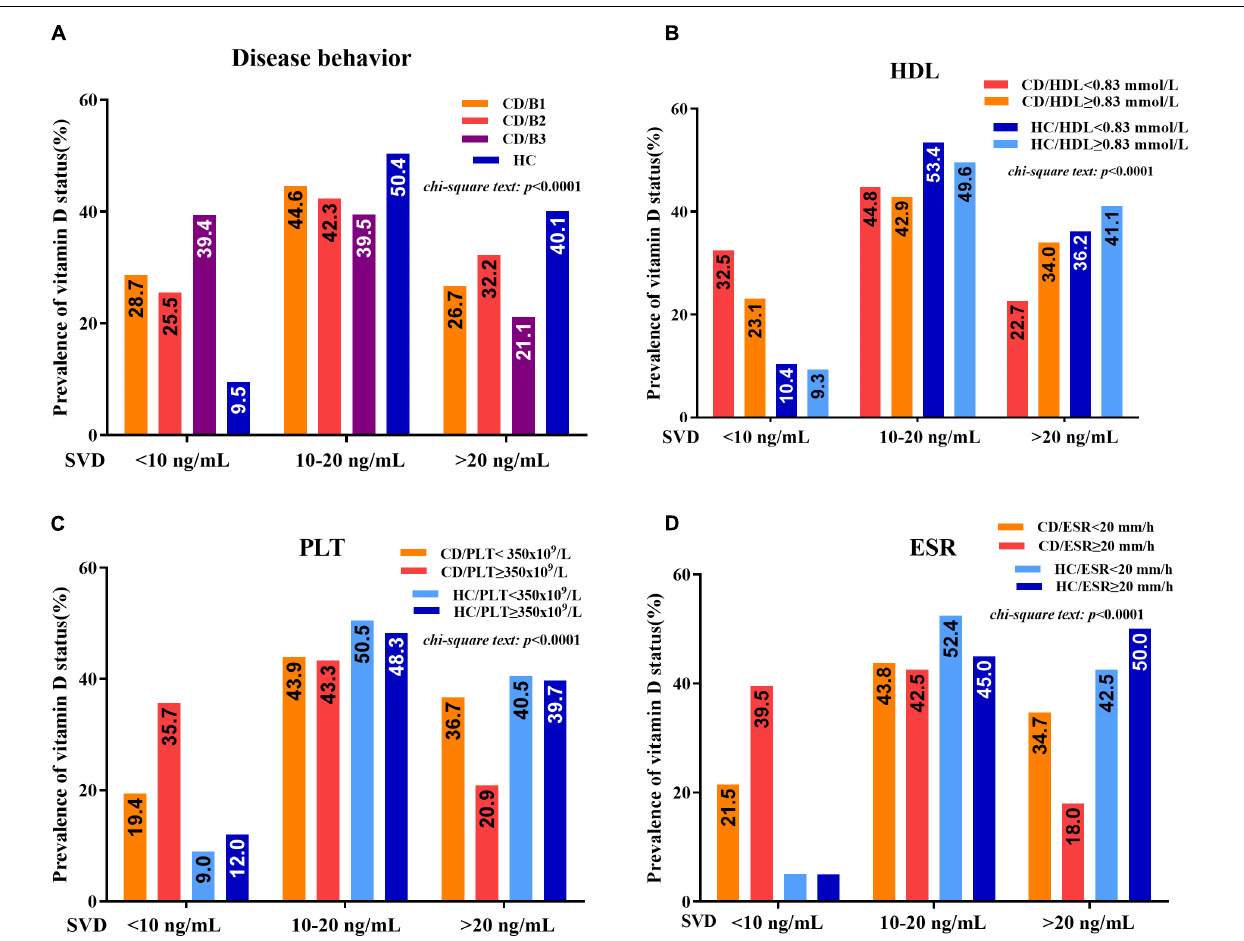
FIGURE 4 | (A) Vitamin D status (percentage of serum vitamin D (SVD) < 10 ng/mL, 10–20 ng/mL, and > 20 ng/mL) between patients with CD and healthy controls concerning different disease behaviors (B1, B2, and B3). (B) Vitamin D status between patients with CD and healthy controls concerning HDL < 1.03 mmol/L and HDL ≥ 1.03 mmol/L. (C) Vitamin D status between patients with CD and healthy controls concerning PLT < 350 × 10 9 /L and PLT ≥ 350 × 10 9 /L. (D) Vitamin D status between patients with CD and healthy controls concerning ESR < 20 mm/h and ESR ≥ 20 mm/h (chi-square